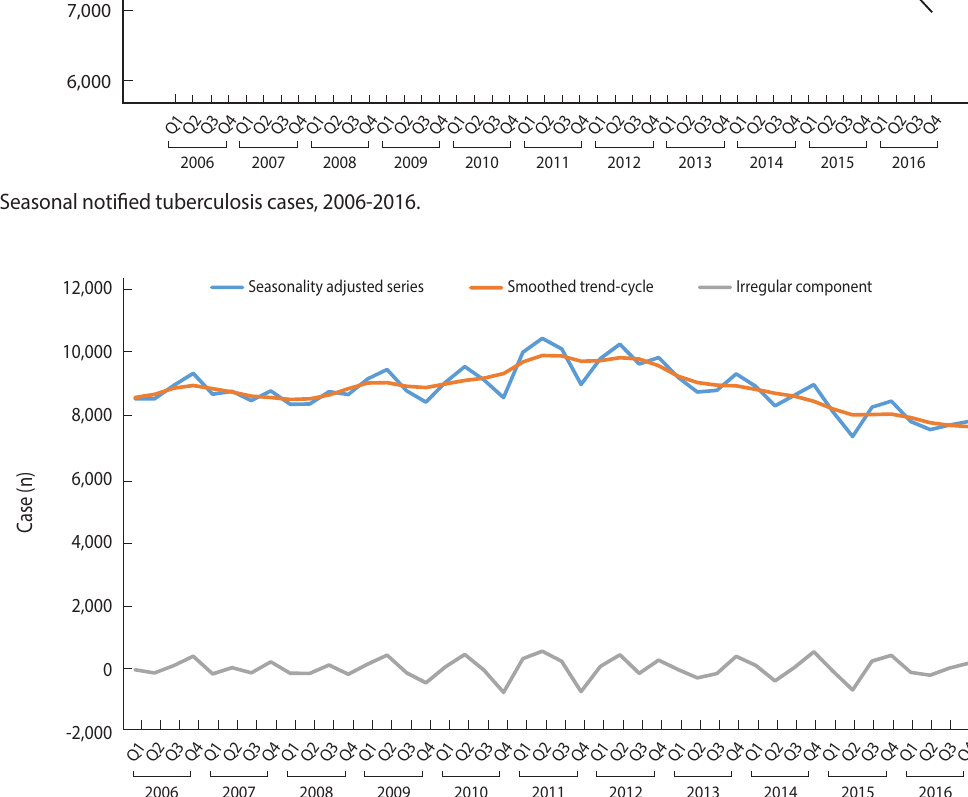
Figure 2. Time series decompositions of tuberculosis cases.